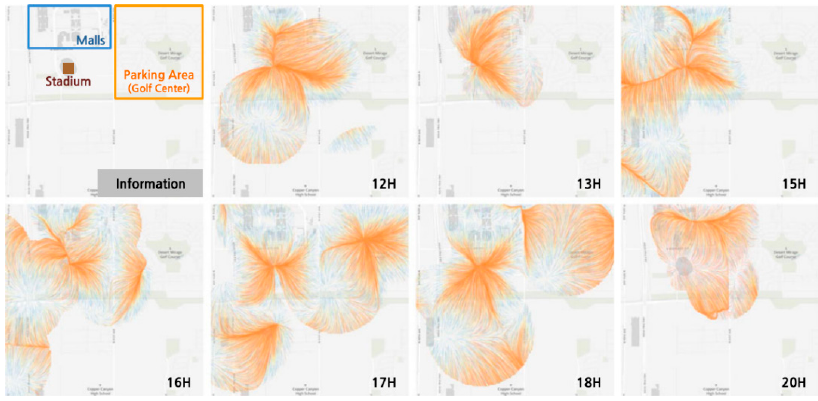
Figure 55. Flow maps detecting converging flow patterns [142].